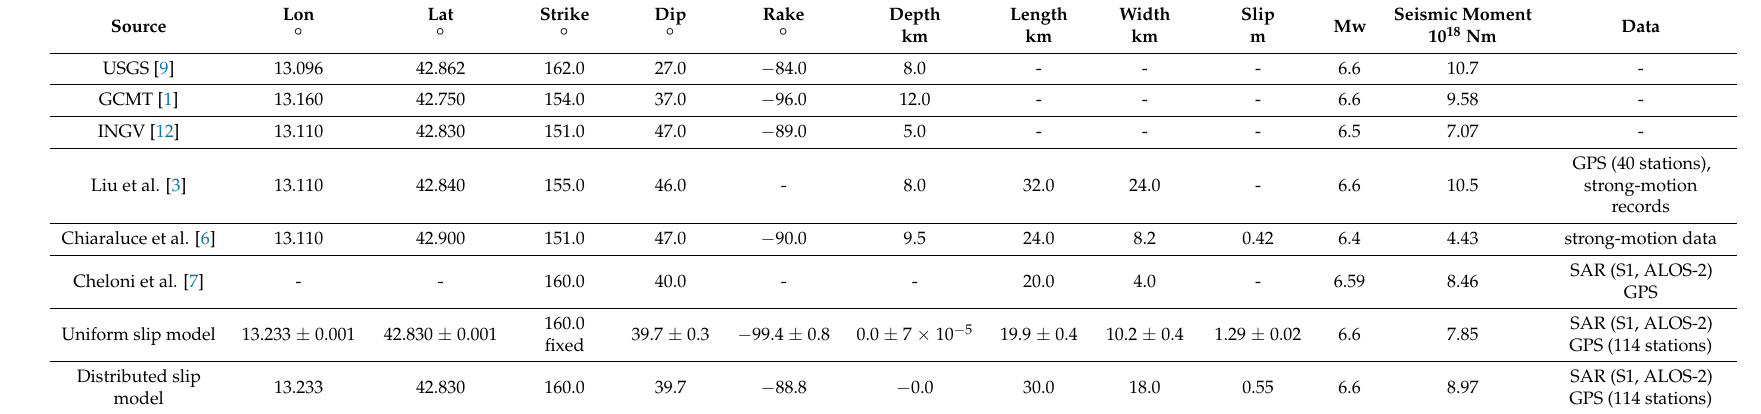
Table 5. Source parameters of the 30 October 2016 Norcia